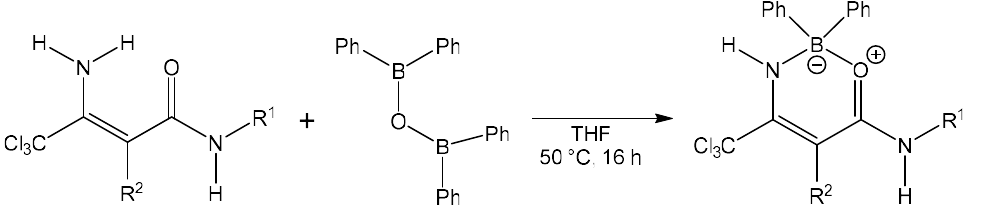
Figure 1. General structure of simple enaminoamides.